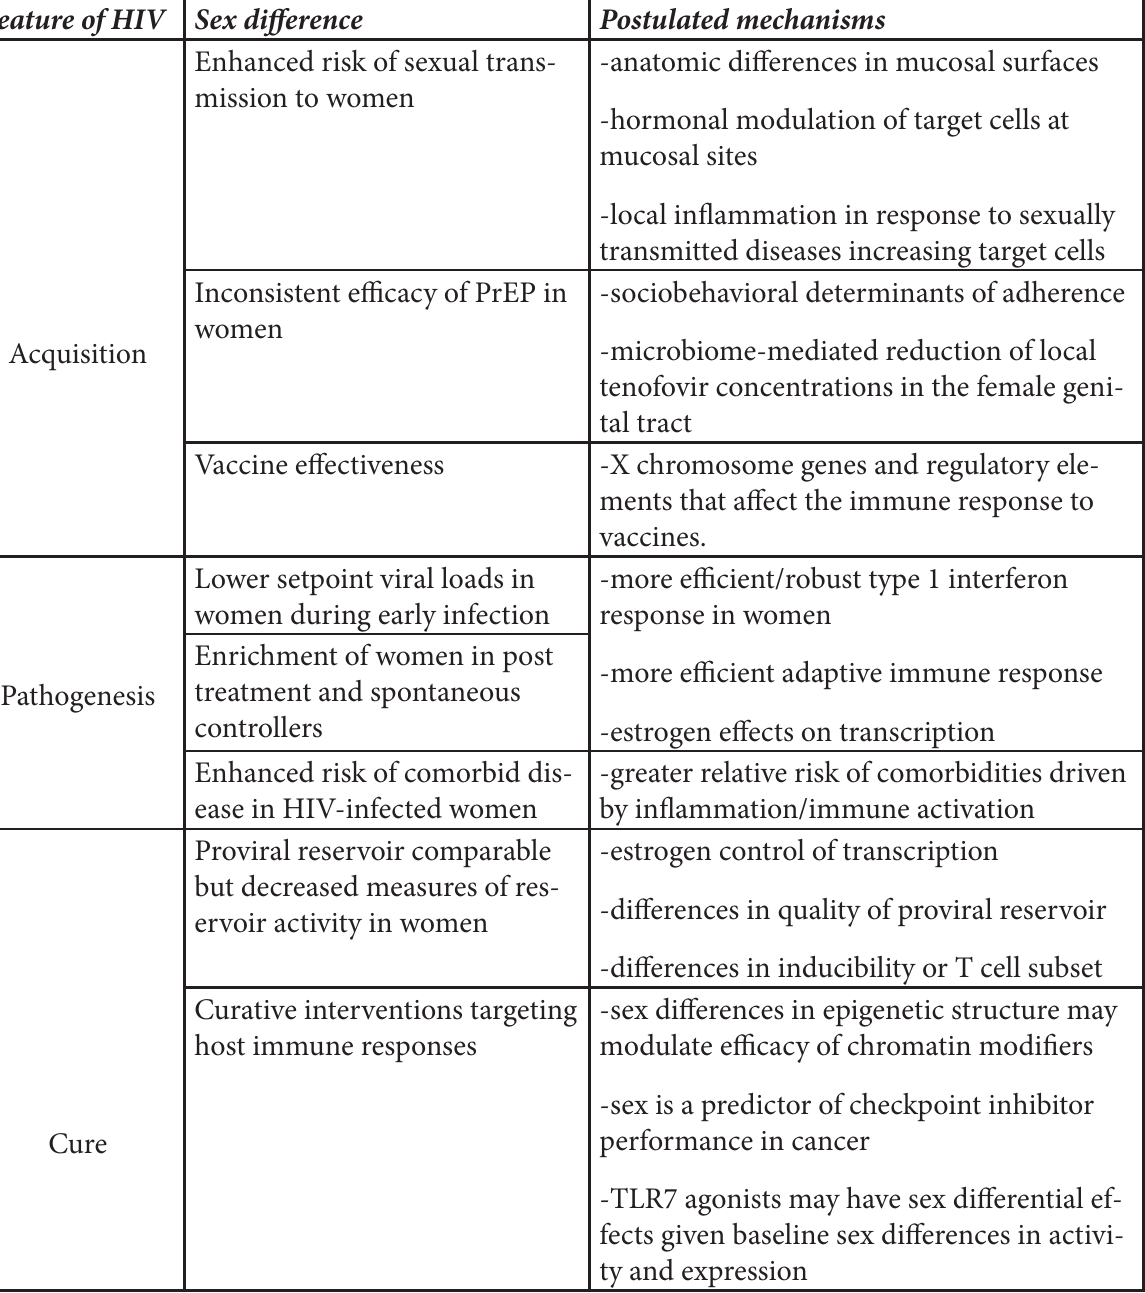
Feature of HIV Sex difference Postulated mechanisms Enhanced risk of sexual trans- -anatomic differences in mucosal surfaces mission to women -hormonal modulation of target cells at mucosal sites -local inflammation in response to sexually transmitted diseases increasing target cells Inconsistent efficacy of PrEP in -sociobehavioral determinants of adherence women -microbiome-mediated reduction of local Acquisition tenofovir concentrations in the female geni- tal tract Vaccine effectiveness -X chromosome genes and regulatory ele- ments that affect the immune response to